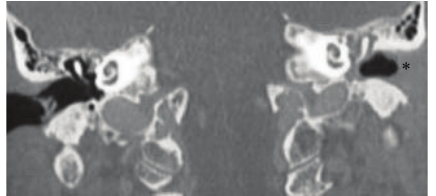
Figure 1: CT imaging depicting otitis media of the left ear with external ear canal obstruction ( ∗ ) due to the cystic lesion.